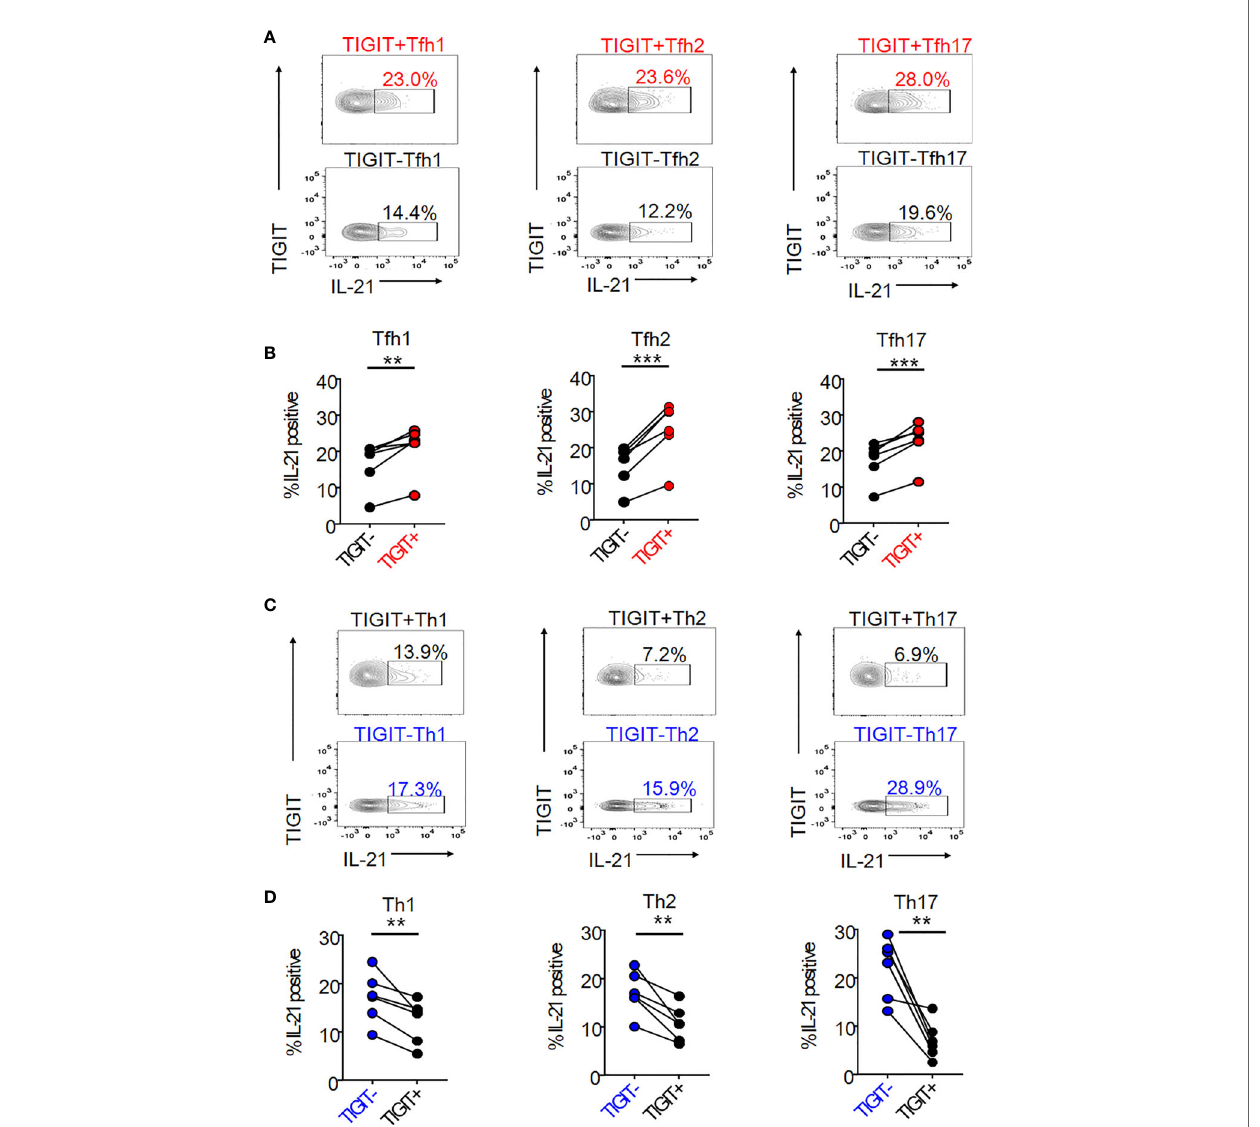
FIGURE 3 | The association of TIGIT expression with IL-21 in Tfh and Th subsets. (A – D) CD4 + T cells were stimulated for 4 hours with phorbol myristoyl acetate and ionomycin. Intracellular IL-21 production in TIGIT + or TIGIT - Tfh cell subsets (Tfh1; CXCR3 + CCR6 - cells, Tfh2; CXCR3 - CCR6 - cells, Tfh17; CXCR3 - CCR6 + cells) or TIGIT + or TIGIT - Th cell subsets (Th1; CXCR3 + CCR6 - cells, Th2; CXCR3 - CCR6 - cells, Th17; CXCR3 - CCR6 - cells) were measured by fl ow cytometry. (C, E) , representative image. (B, D) multiple comparison of the proportion of IL-21 producing cells in Tfh cell subsets or Th cell subsets (n=6). (B, D) paired t-test. ***p<0.001,